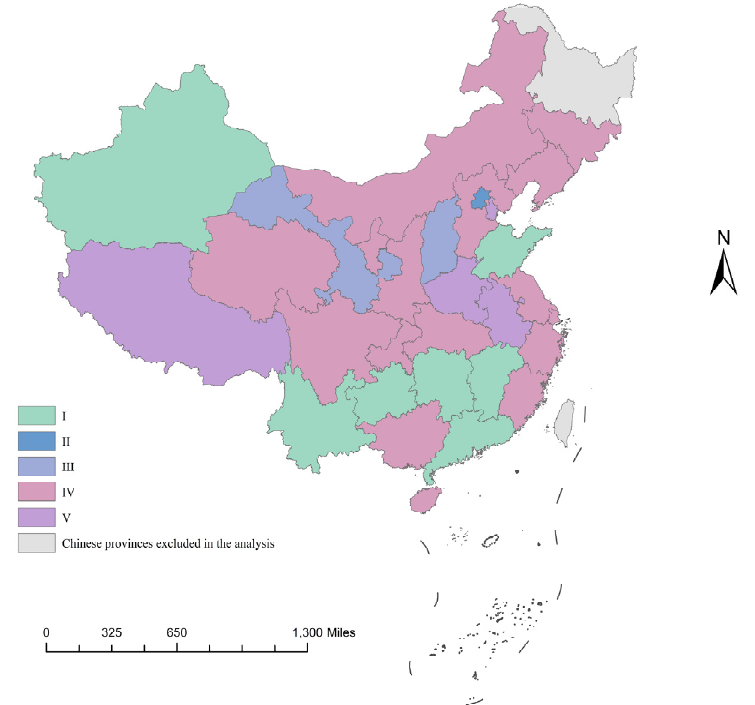
Figure 5. Spatial distribution of the types of different provinces. Note: Based on the results of Figure 4. Figure